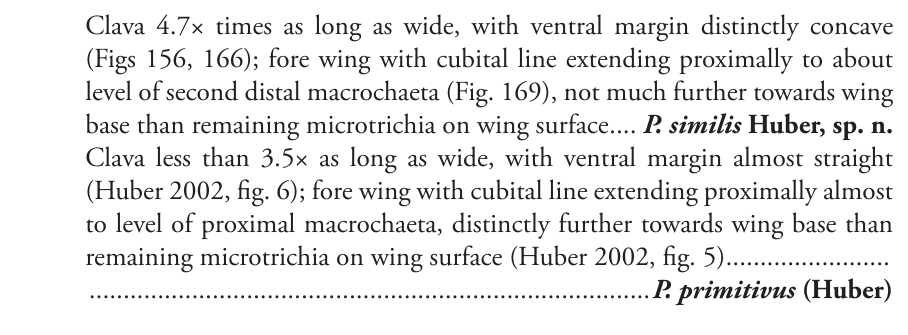
Borneomymar primitivum Huber, 2002: 49 (description, figs 5, 6). Comment. In Huber (2002) the female and male symbols in the material examined sections were inadvertently either deleted or were replaced by a question mark.